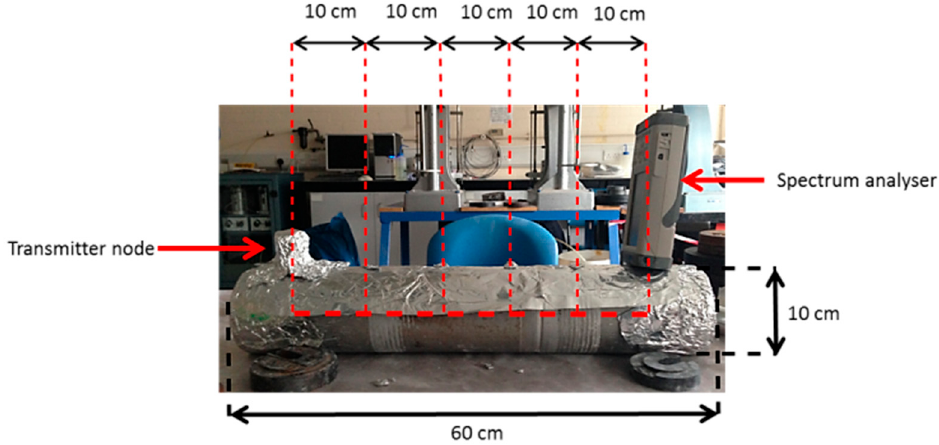
Figure 3. Final test setup showing hole spacing and grounded shielding.